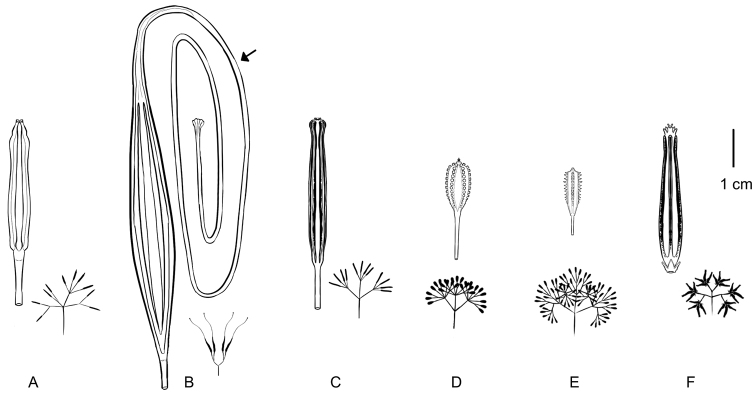
Comparison of size and morphology of ripe fruits (anthocarps) amongst members of Ceodes, Pisonia and Rockia (Nyctaginaceae). The outline of infructescences are shown below each anthocarp ACeodes
brunoniana (based on St. John 11272 (US-01258187)) BCeodes
longirostris (based on Brass 2972 (HUH-00046918)). Note the extremely long rostrum at the tip of the anthocarp (indicated with an arrow) CCeodes
umbellifera (based on Foxworthy 593 (US-03661041)) DPisonia
aculeata L. (based on Caraballo 3464 (IJ)) EPisonia
grandis (based on Fosberg 24357 (US-00959523)) FRockia
sandwicensis (based on Lorence 6305 (US-00452890)). Illustration credit: Ramos Sepúlveda.